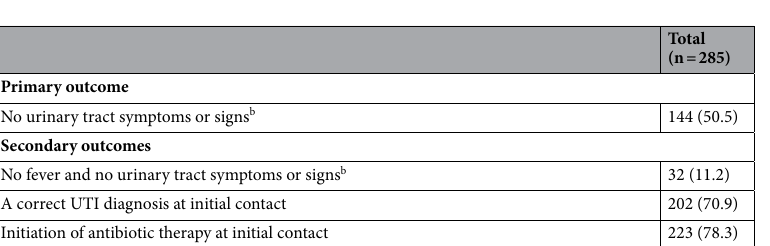
Table 2. Primary and secondary outcomes a . a Values are expressed as numbers with the percentages of the total numbers, unless otherwise stated. b Urinary tract symptoms include dysuria, urgency, frequency, suprapubic pain, flank pain, back pain, costovertebral angle tenderness or lower abdominal tenderness on physical examination at the time of the initial presentation. UTI, urinary tract